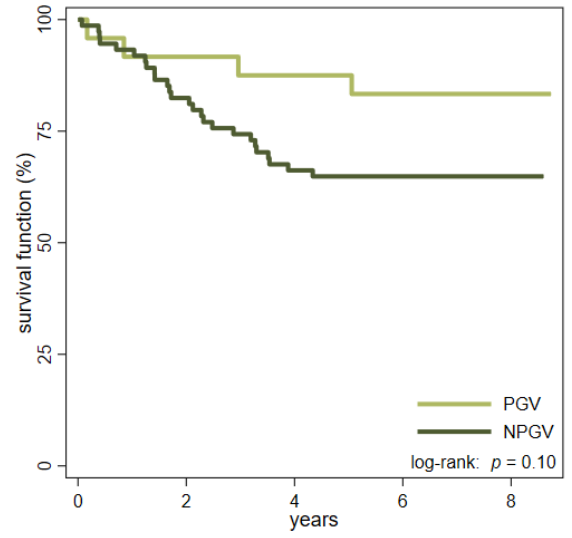
Figure 1. Kaplan-Meier curves estimating the overall survival in patients with pathogenic germline variants (PGV) and no pathogenic germline variants